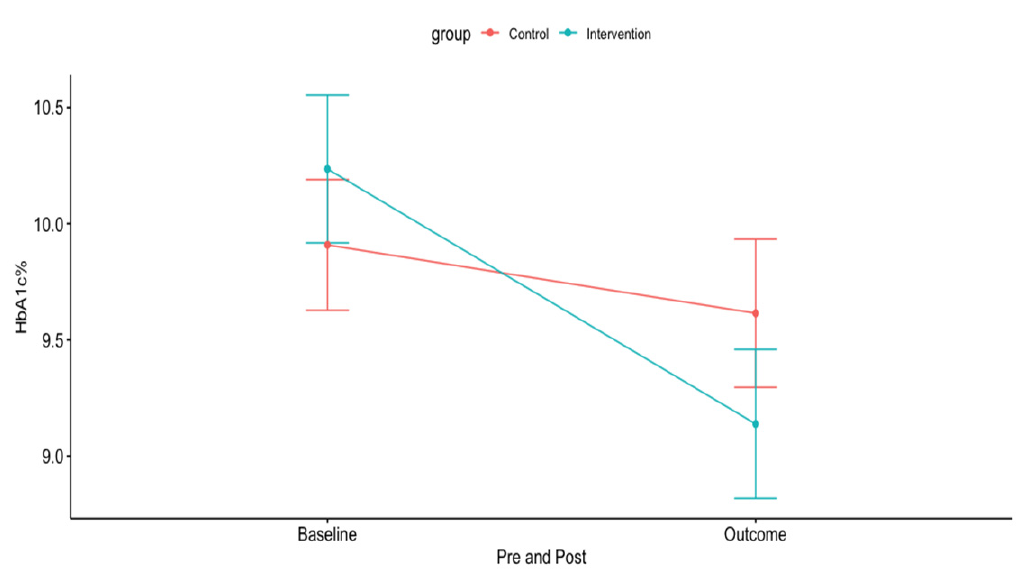
Figure 2. Pre-post hemoglobin A1c (HbA1c) reduction in the control and intervention arms. Detailed glycemic results are shown in Table 2.